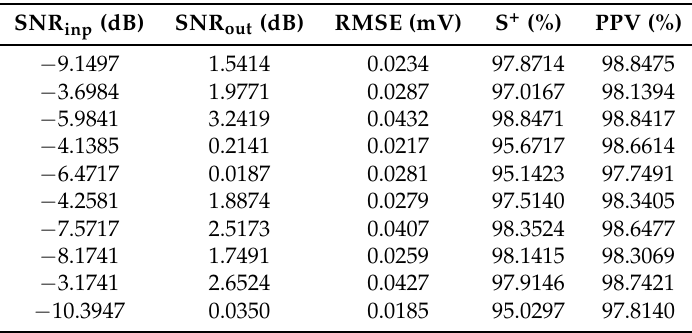
Table 3. Experimental results when using the NLMS